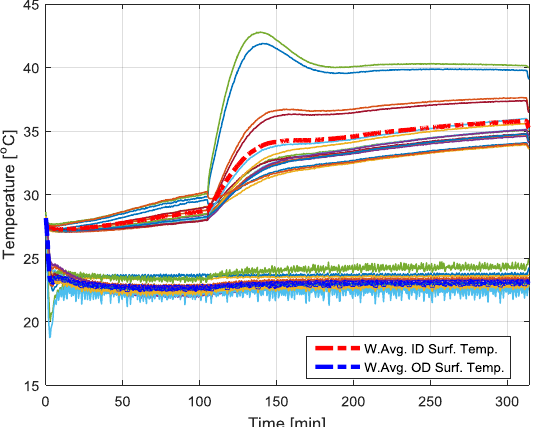
Figure 6. Variation of specimen surface temperature with time during Test 1.